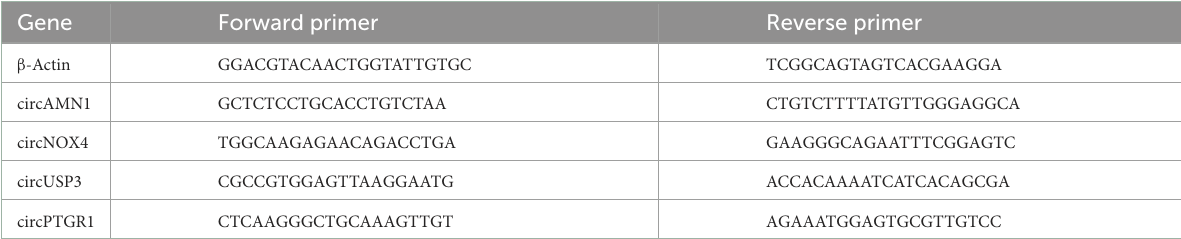
TABLE 1 Primers of humans used for real-time quantitative PCR analysis.